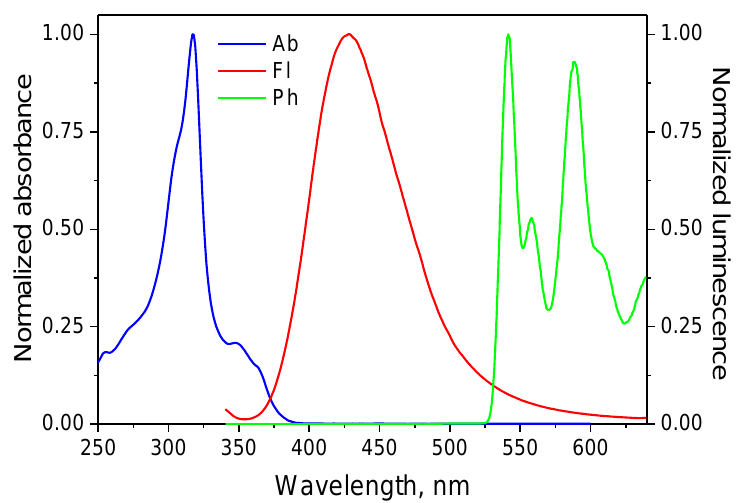
Figure 3. Electronic absorption (Ab), fluorescence (Fl) and phosphorescence (Ph) spectra of acenaphto[1,2-b] quinoxaline (AN2) in anhydrous ethanol; the absorption and fluorescence spectra were recorded at RT whereas the phosphorescence spectra were recorded at 77 K; Ex = 325 nm.